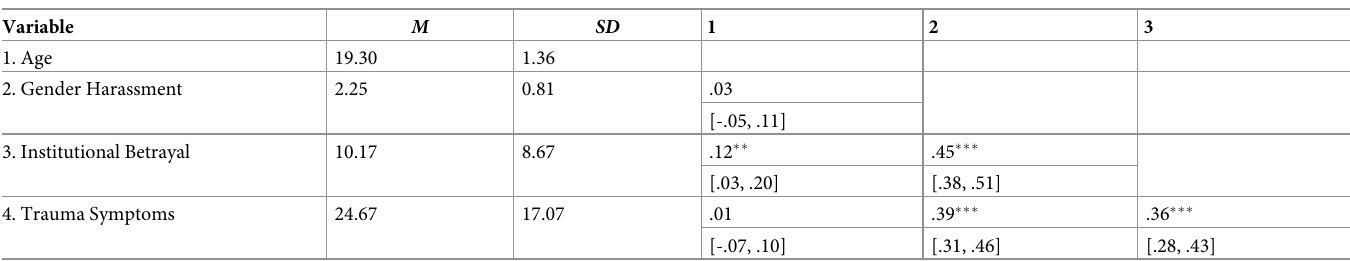
Table 2. Means, standard deviations, and correlations of continuous variables (N = 535).